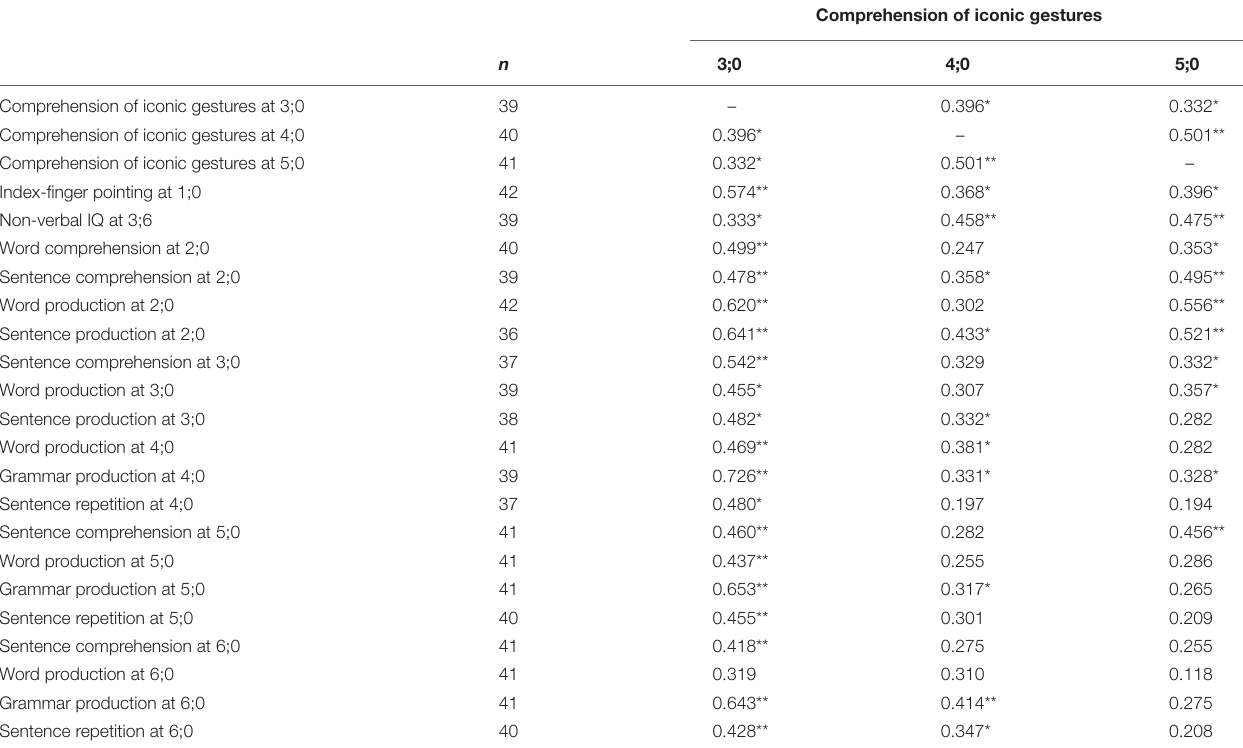
TABLE 3 | Relation between comprehension of iconic gestures, index-finger pointing at 1;0 and language abilities